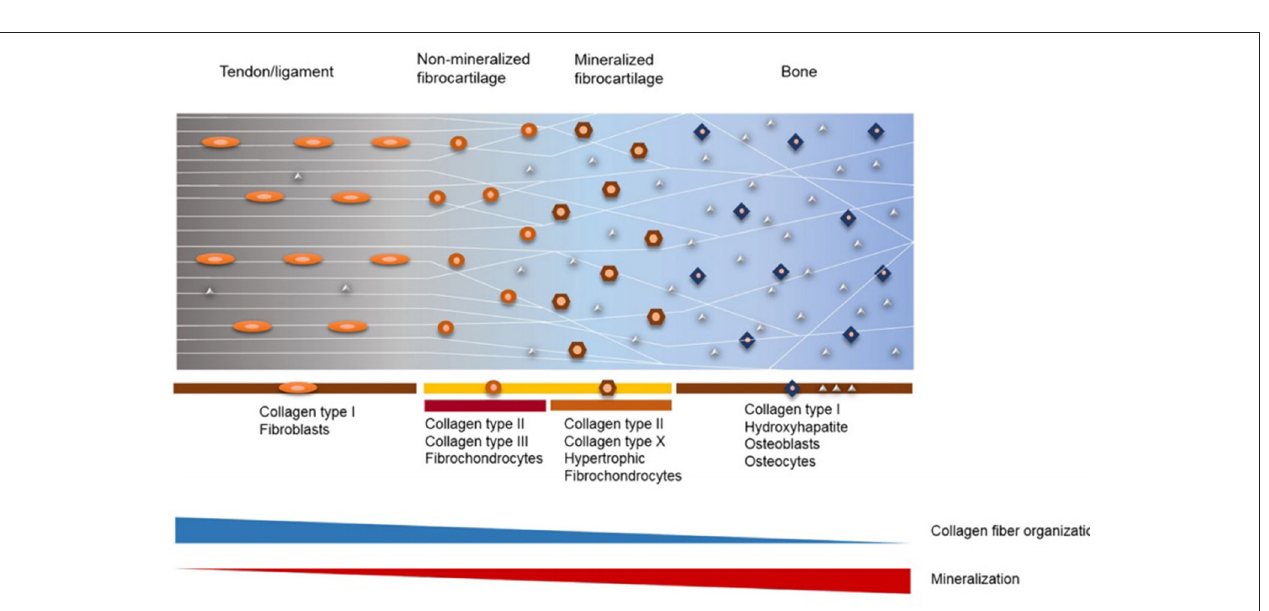
FIGURE 2 | Structure and composition of fibrocartilaginous entheses of tendon/ligament-bone interface (Reprinted by permission from Elsevier, Advanced Drug Delivery Reviews, Tellado et al., 2015 copyright © 2015). a worldwide health problem, the most common form of arthritis, and it mainly occurs at the cartilage-bone